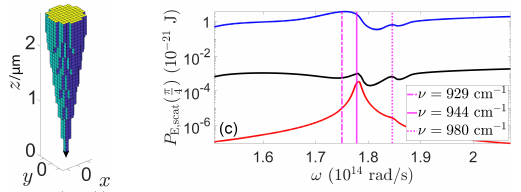
Figure 3. Far-field spectrum of a Si scattering tip (black curve) 10nm above a planar SiC substrate compared to the result of a single dipole model (small: red curve, large: black curve). The tip is treated within a discrete dipole approximation as in Ref.